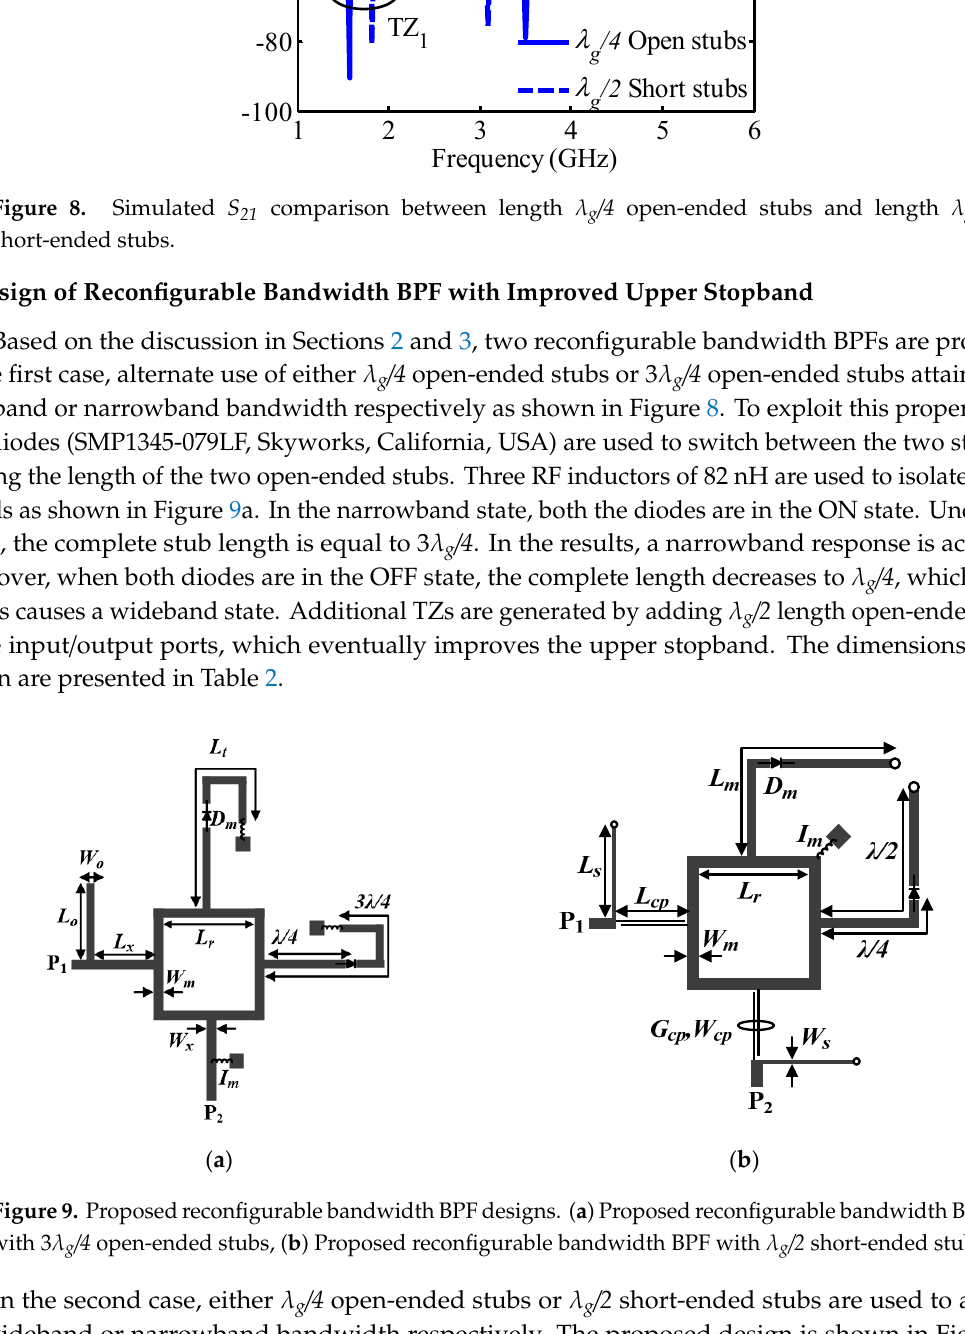
Figure 9. Proposed reconfigurable bandwidth BPF designs. ( a ) Proposed reconfigurable bandwidth BPF with 3 λ g /4 open-ended stubs, ( b ) Proposed reconfigurable bandwidth BPF with λ g /2 short-ended stubs.